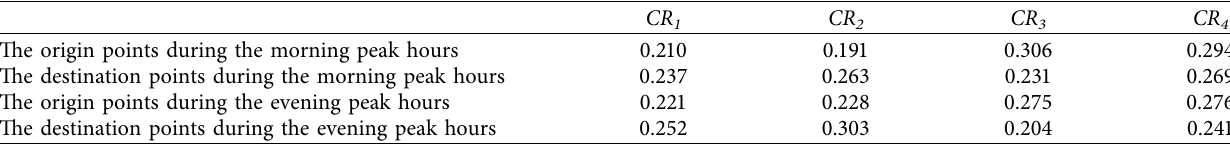
Table 4. In Cluster 1, the origin and destination points